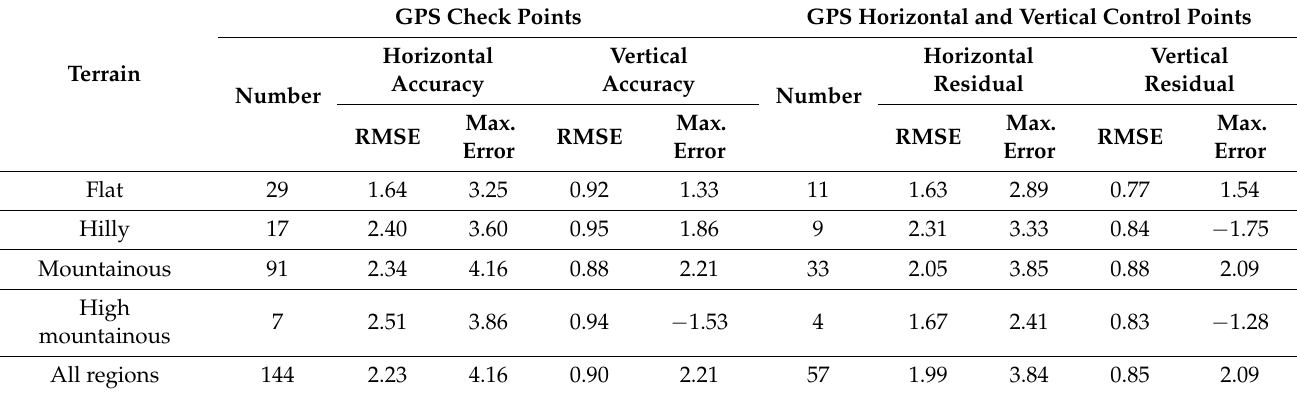
Table 8. Experimental results of integrated processing of GF7 experimental data (third